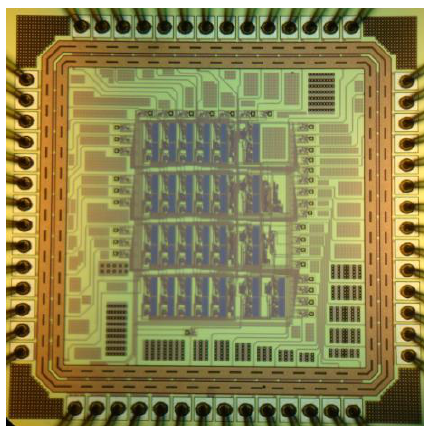
Figure 11. MLPNN chip